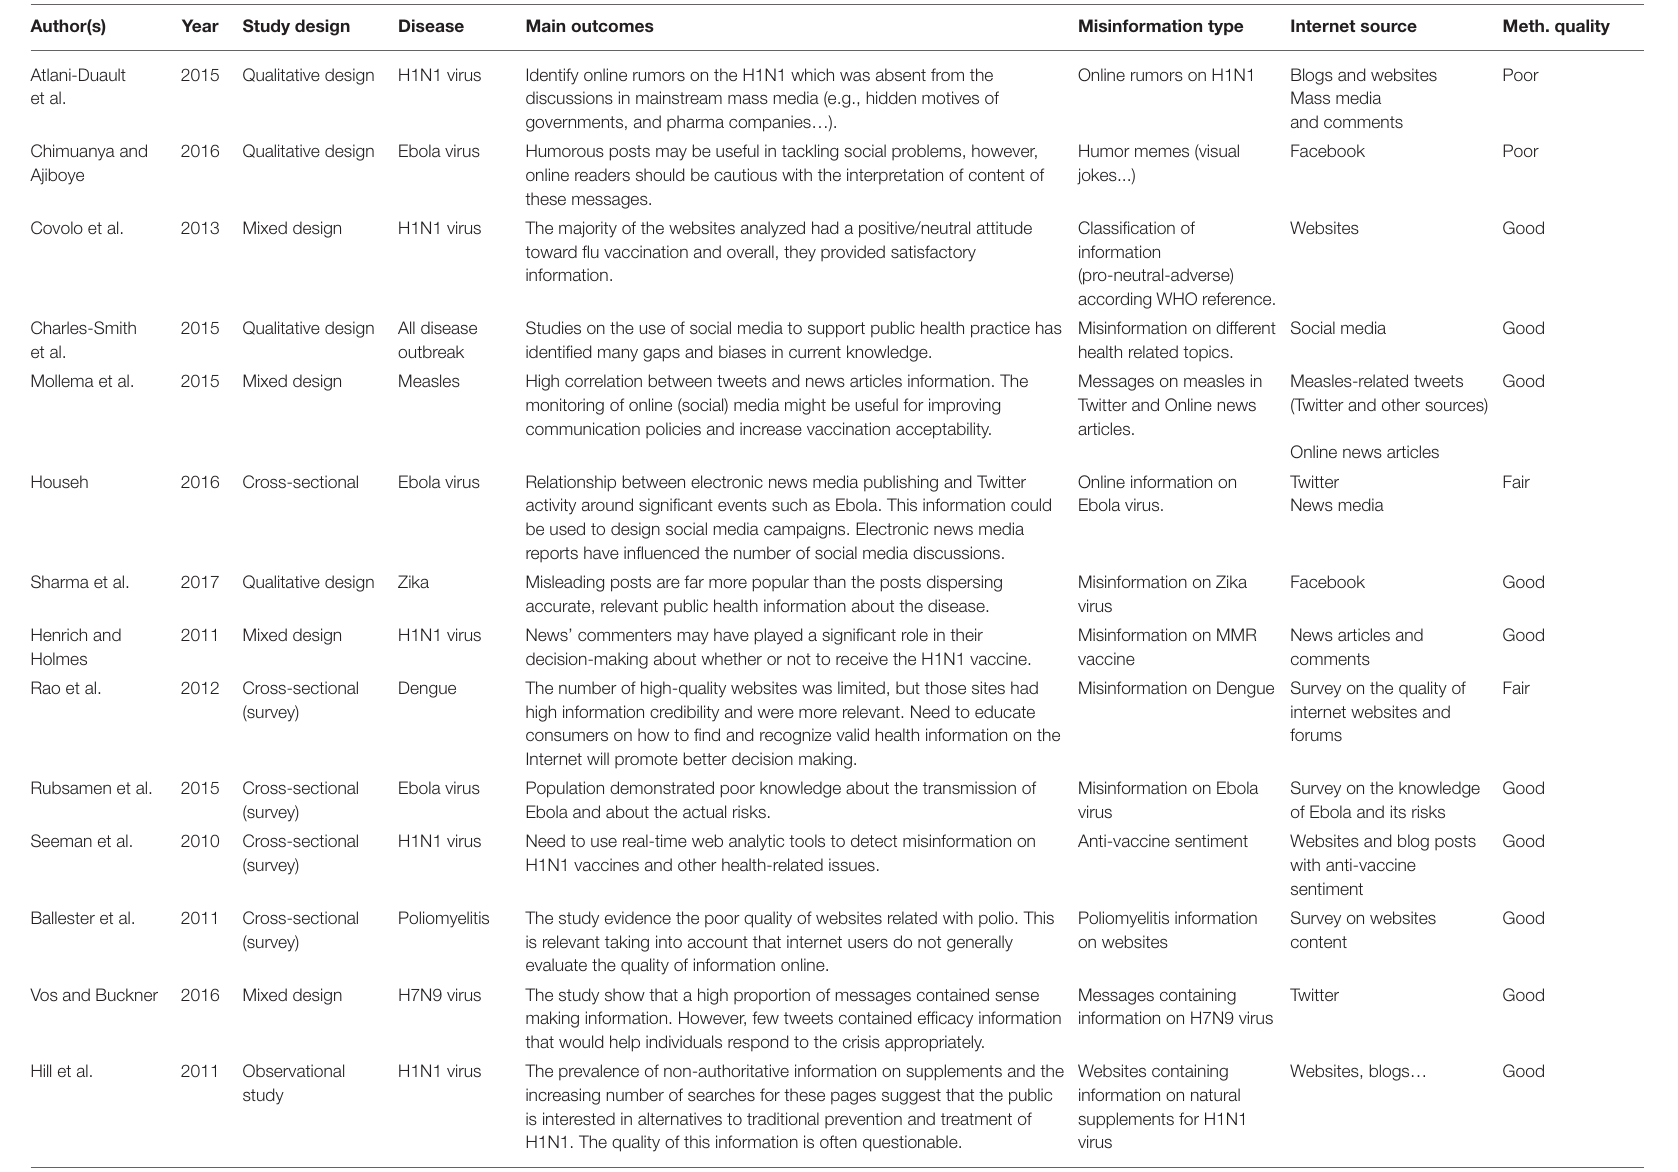
TABLE 2 | Description of the studies